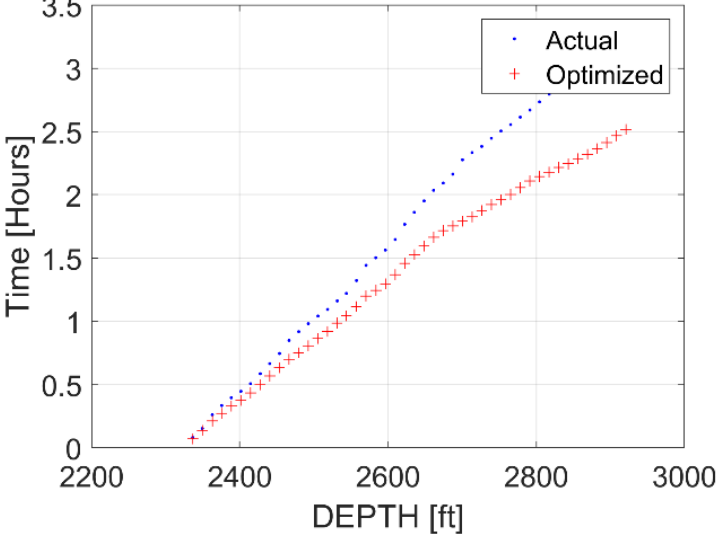
Figure 11. Time consumed to drill the